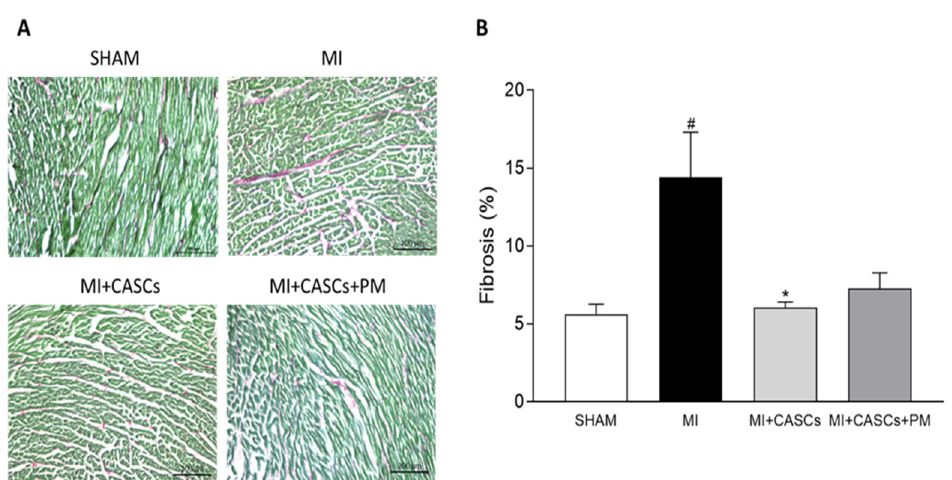
Figure 3. Interstitial collagen deposition in the LV. ( A ) Representative examples of collagen deposition (red) in the LV. Scale bar = 200 µm. ( B ) Quantification of collagen content in LV transversal sections 4 weeks after surgery of SHAM ( n = 4), MI ( n = 11), MI + CASCs ( n = 10), and MI + CASCs + PM ( n = 5). Data are expressed as mean ± SEM. * denotes p < 0.05 vs. MI, # denotes p < 0.05 vs. SHAM.